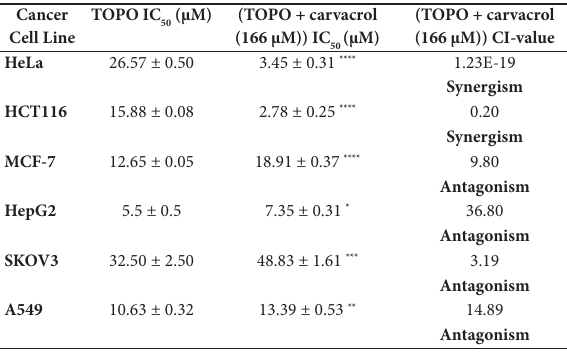
Table 1. Effect of carvacrol/TOPO combination therapy on the growth of different cancer cell lines and their combination